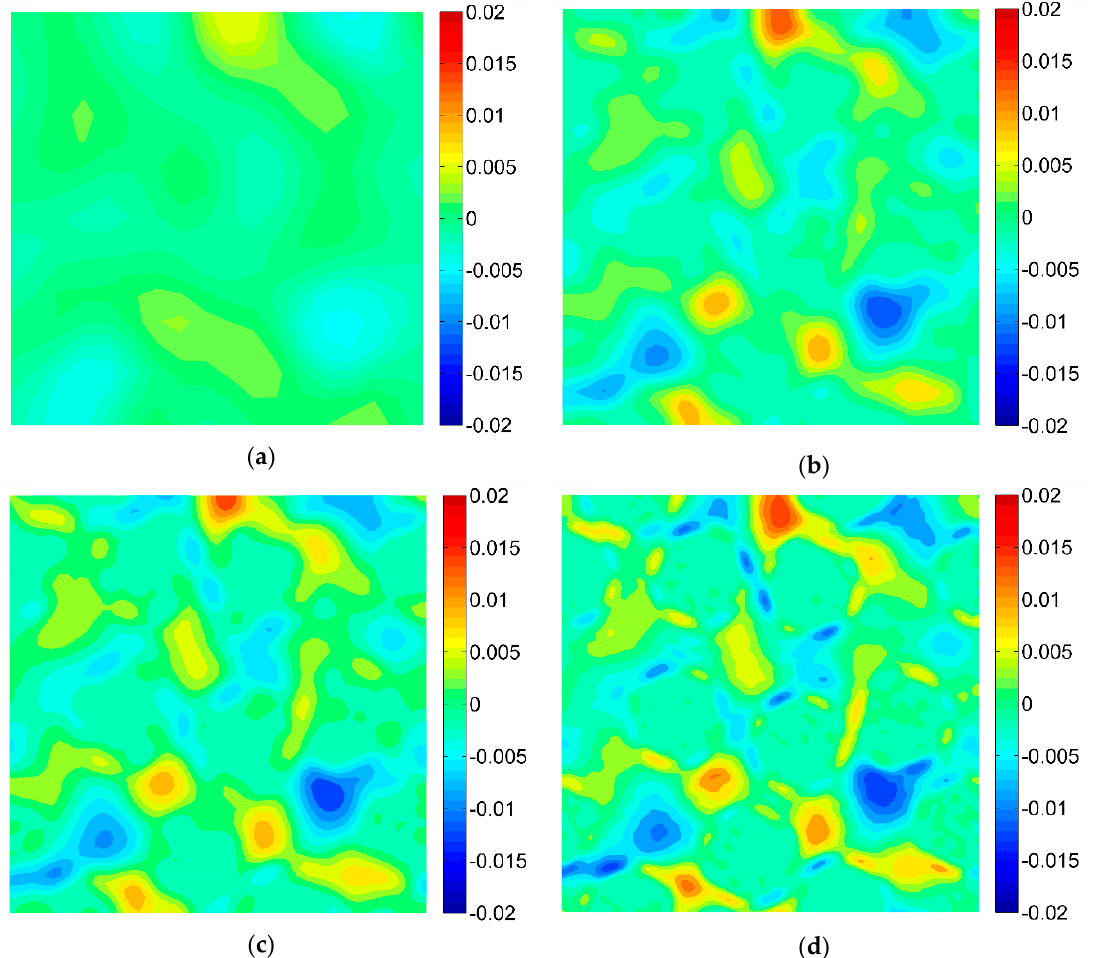
Figure 12. Distribution of strain ε 12 obtained for Material 1 with consideration of different speckle sizes, grid of squares: ( a ) 50 × 50, ( b ) 100 × 100, ( c ) 150 × 150, ( d ) 200 × 200.